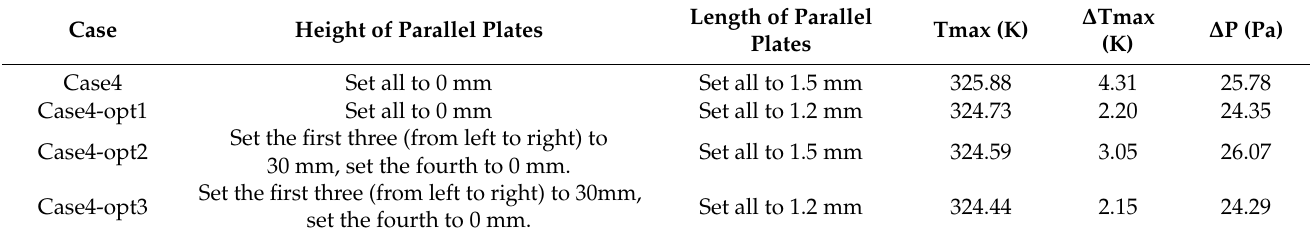
Table 1. Specific measures corresponding to each scheme.